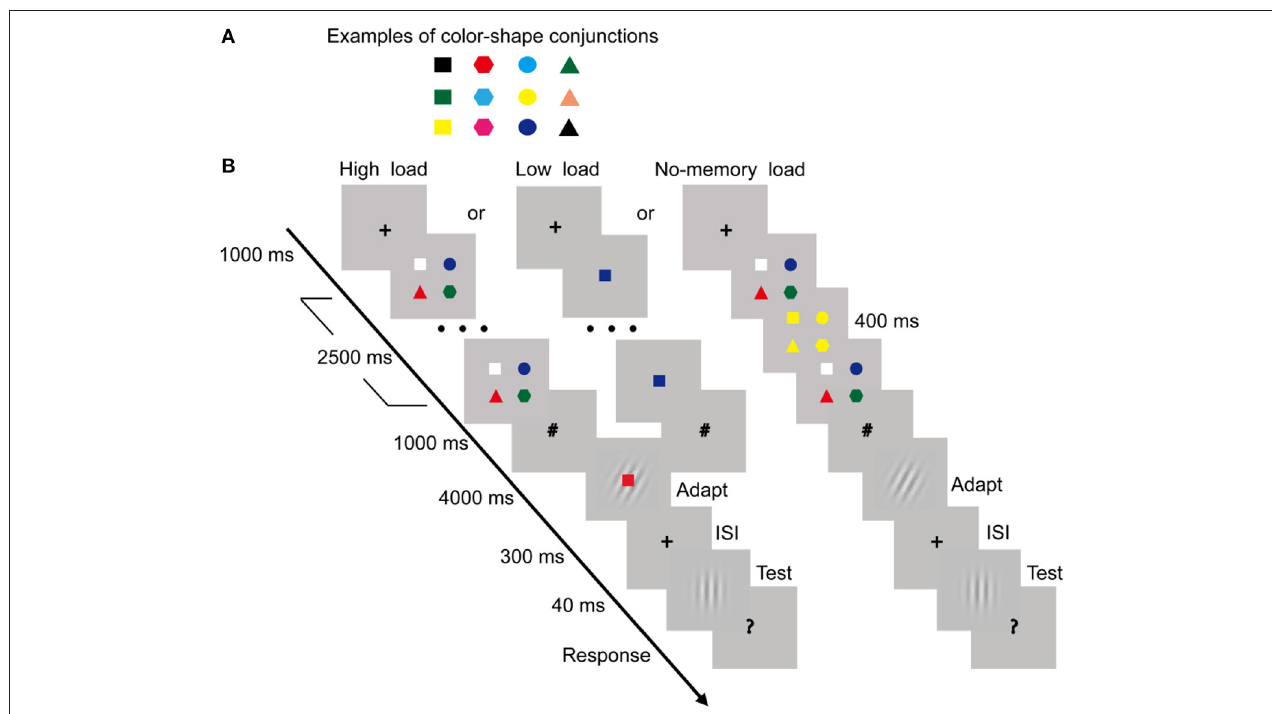
FIGURE 3 | Examples of color-shape conjunctions (A) and trial procedures of the low-load, high-load, and no-memory load condition (B) in Experiment 2. The same trial procedure as that of Experiment 1 was used, except that the color-shape conjunctions rather than digits were used in the working memory load task (see section Procedure for